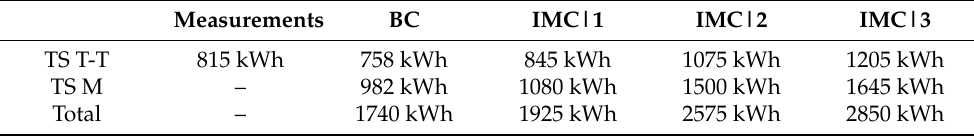
Table 7. Daily energy for the TS T-T and the TS M considering the four simulation scenarios.